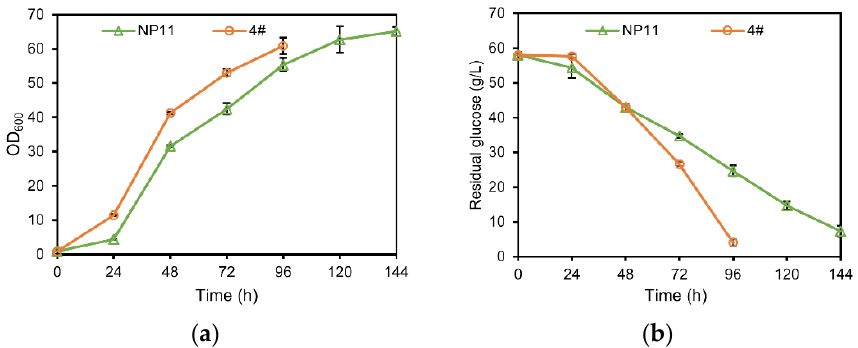
Figure 1. Results of cell density (OD 600 ) and glucose consumption time course in shaking flask culture of haploid strain R. toruloides NP11 and diploid strain R. toruloides 4#. ( a ) The growth curve of strains in nitrogen-limited culture; growth was measured as the turbidity of culture broth at 600 nm every 24 h. ( b ) Residual glucose concentration curves of strain NP11 and 4#.